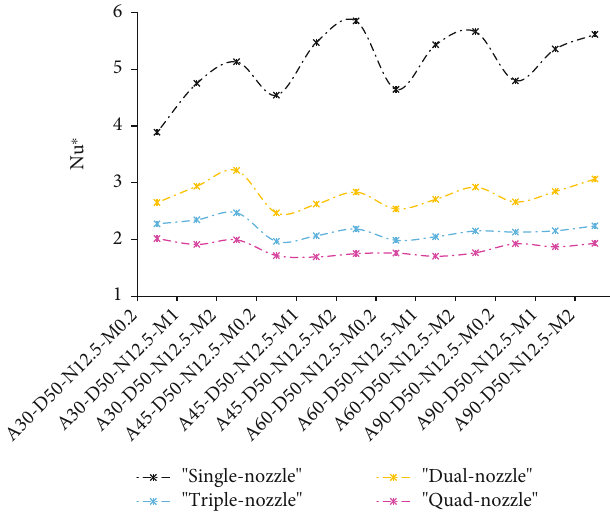
Figure 6: Ratio of modi fi ed Nu to unmodi fi ed Nu.